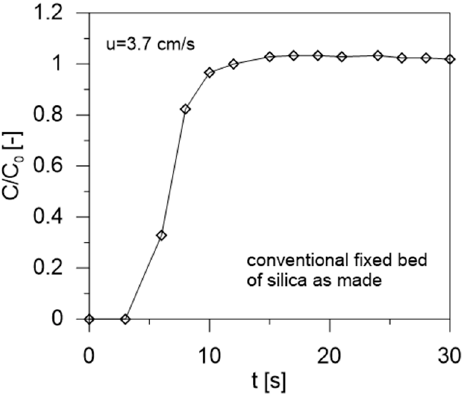
Figure 11. Breakthrough curve for as-made silica in a conventional fixed bed.